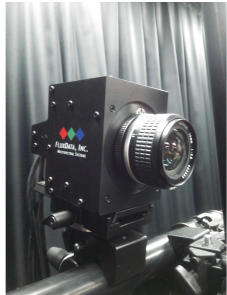
Figure 7. Multispectral camera “FluxData FD-1665 (USA)”.